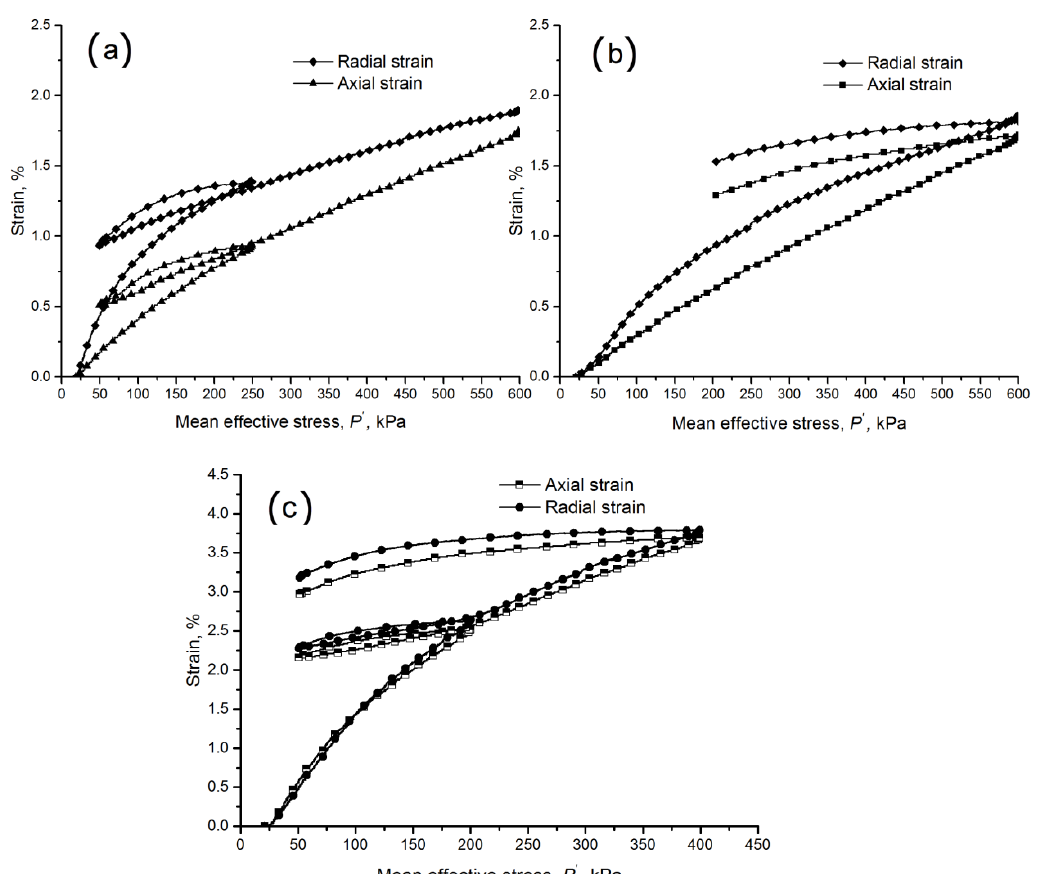
Figure 7. Radial and axial strains with mean effective stress of intact and disturbed soils during an isotropic compression; ( a ) ISO-4, ( b ) ISO-5, and ( c ) disturbed soil.